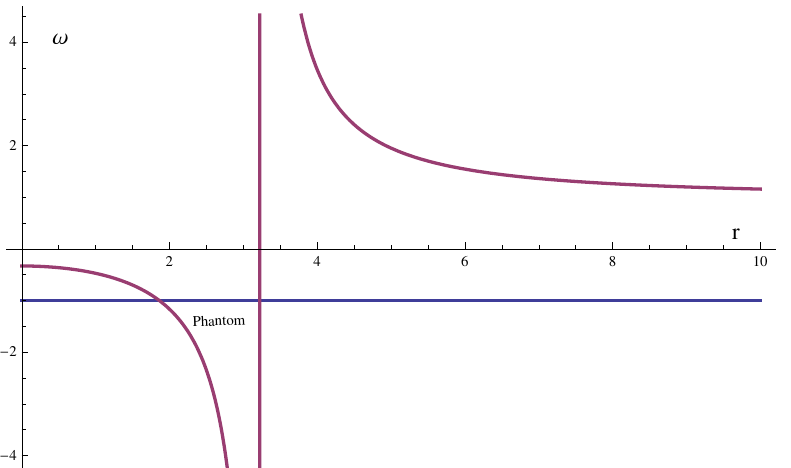
Figure 3. Plot of state parameter, ω = p r / ρ , as a function of the throat radius, r 0 , in Planckian units, for ξ = 1 and r = r 0